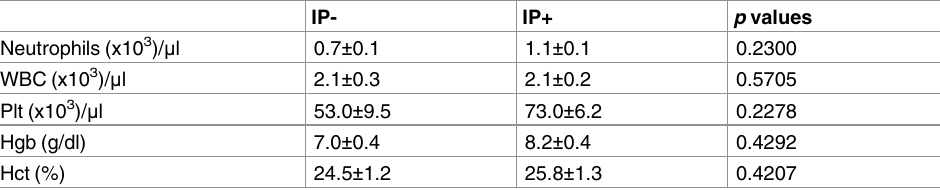
WBC = white blood cells Plt = platelets Hct = haematocrit Hb = haemoglobin. Normal range: neutrophils (x10 3 )/ μ l = 2–7.5; platelets (x10 3 )/ μ l = 150–450; white blood cells (x10 3 )/ μ l = 4.5– 10.5; Hct (%) = 35–60; Hgb (g/dl) = 11–18. These parameters were measured in the blood of VL patients without intestinal parasite co-infection (IP-) and in VL patients co-infected with intestinal parasites (IP+), using a CELL-DYN 1800 Haematology Analyser, USA. Statistical significance was established using a Mann-Whitney test. reported in Table 2 with maximum number of infections of 1,2 and 2, respectively), co-infec- tion patterns were investigated for hookworms, S . mansoni and A . lumbricoides using Fisher exact test (for the three possible pairs: hookworms and S . mansoni , hook worms and A . lumbri- coides and S . mansoni and A . lumbricoides ). In all cases it was found to be not significant. All VL patients recruited at the LRTC presented with severe disease. Disease severity in VL patients has been associated with hepatosplenomegaly, low BMI, pancytopenia, anaemia and high parasite burden in splenic aspirates. Our results show hepatosplenomegaly in all but one patient (these measurements were not taken in two patients); that the majority of the VL patients were malnourished: 11 had a normal BMI ( > 18.5), 23 were moderately malnourished (BMI 16.5–18.4) and 26 were severely malnourished ( < 16.5) and there was no significant dif- ference in BMI between VL patients with and without co-infection with intestinal parasites. Of note, we collected only one stool sample, however we maximised our chances to detect para- sites by using three different techniques: direct saline wet mount, Kato-katz and "formol ether concentration" techniques. Furthermore, the neutrophil and white blood cell counts of both cohorts of VL patients were below the normal range. It is likely that the undetectable or very low percentages of eosinophils are due to the severe pancytopenia characteristic of VL patients. Finally, Leishmania parasites were present in the spleen or bone marrow aspirates of both patient cohorts. The results showing that VL patients are malnourished are in agreement with our previous results, showing that the large majority of VL patients are malnourished [18, 19]. Intestinal parasitic infections have long been associated with malnutrition in children [20, 21]: clinical manifestations of intestinal parasitic infection range from acute or persistent diarrhoea to dysentery, resulting in inflammation and nutrient malabsorption [22]. However, studies about intestinal parasitic infections and malnutrition in adults are less common and some- times conflicting. For example, a study performed in Brazil showed that hookworm infection was associated with low BMI in adults [23]. But in a recent study performed in Ethiopia, the prevalence of undernutrition was similar in individuals infected with or without intestinal par- asite infections [24]. In line with these results we show that the BMI of VL patients co-infected with IP were similar to those of VL patients. VL patients in the North West of Ethiopia are usu- ally admitted with progressed, severe visceral leishmaniasis and since undernutrition and therefore a low BMI is characteristic of acute disease in patients with VL, [18, 19], any impact